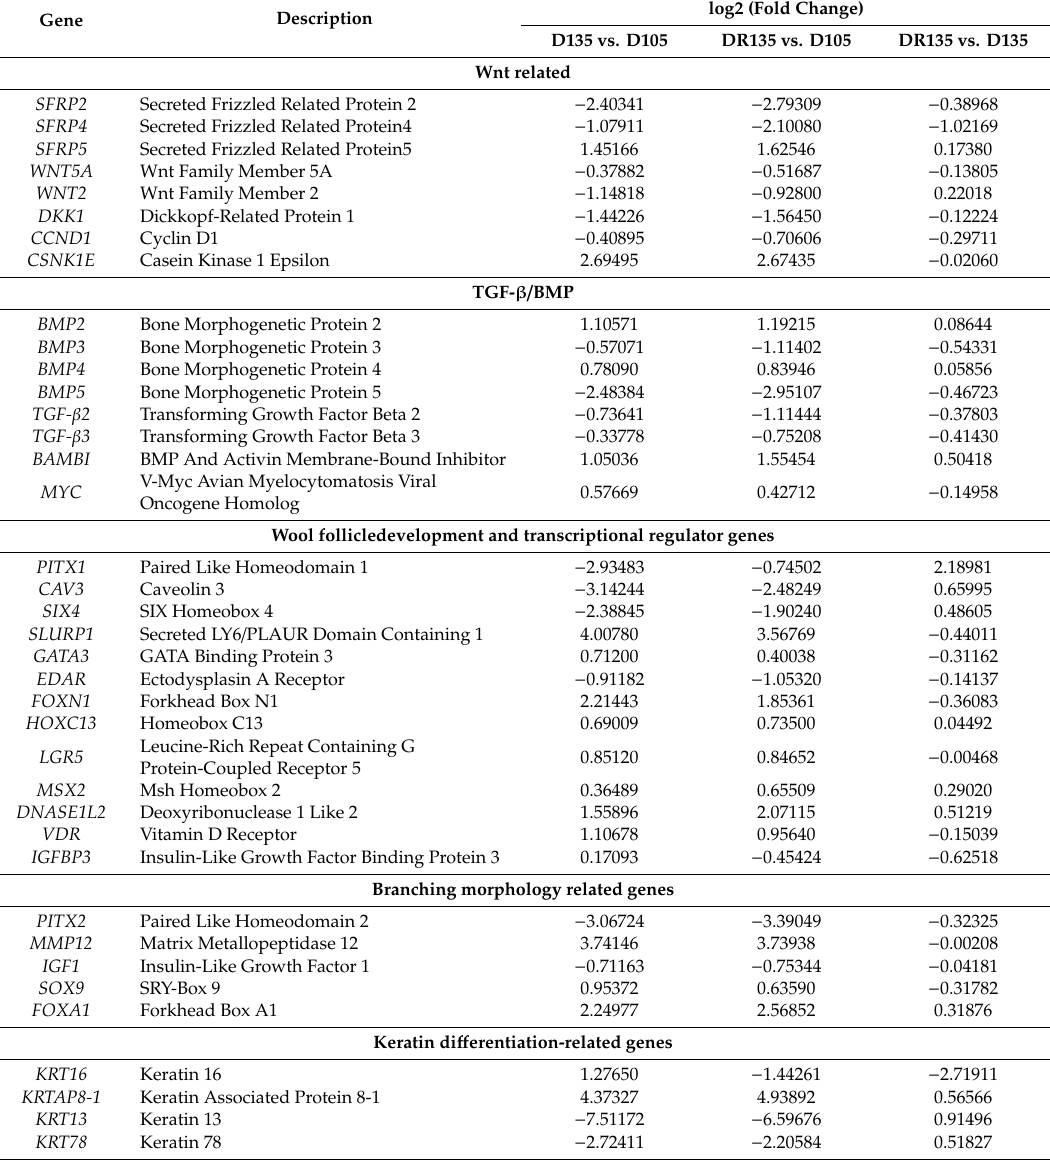
Table 2. Potential key genes that are di ff erentially expressed related to SF